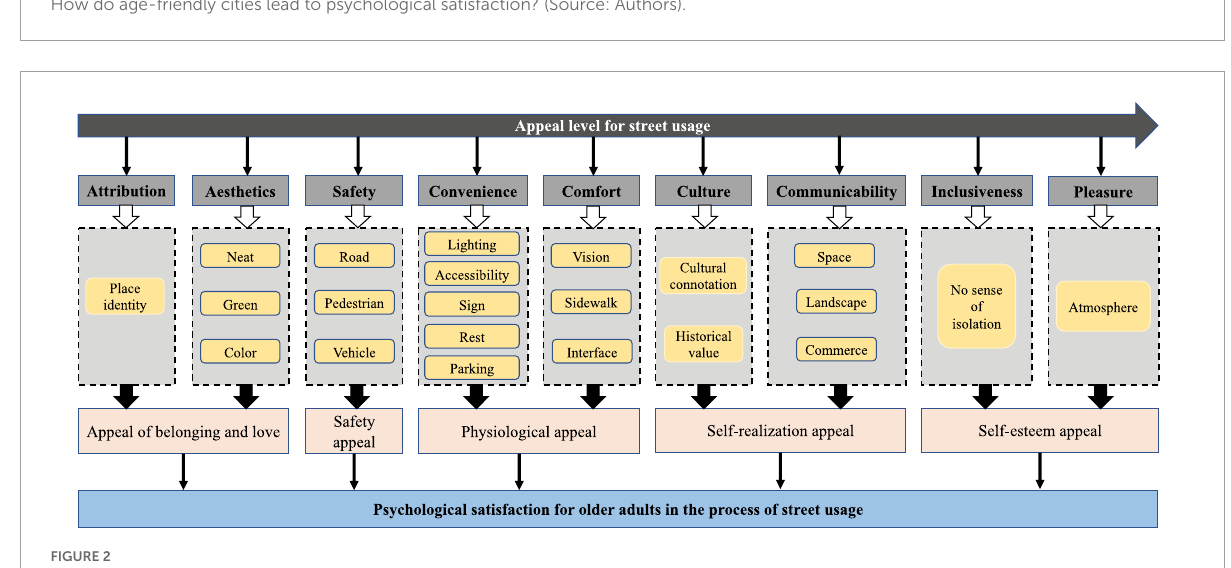
FIGURE2 Street usage promoting psychological satisfaction for older adults (Source: